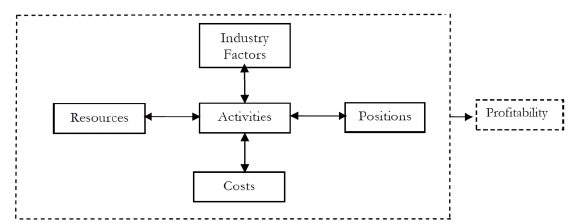
Figure 4. Business model by Afuah.